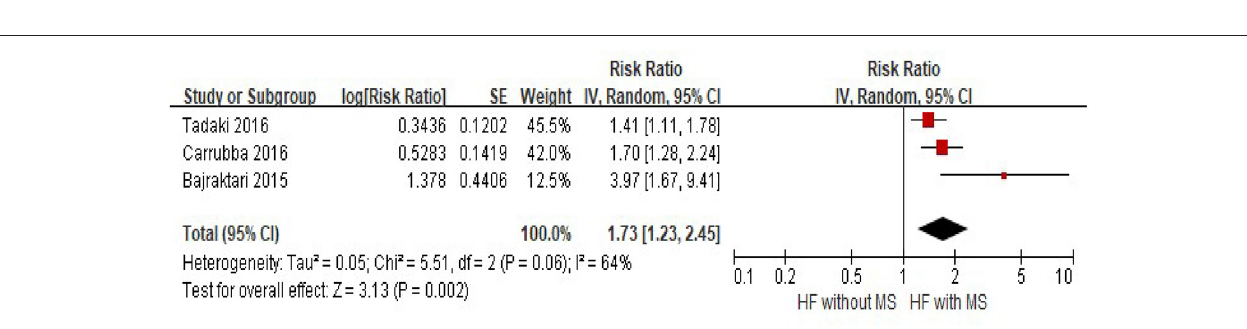
FIGURE 3 | The association of MS and the risk of cardiovascular mortality in HF patients. CI, confidence interval; HF, heart failure; MS, metabolic syndrome.